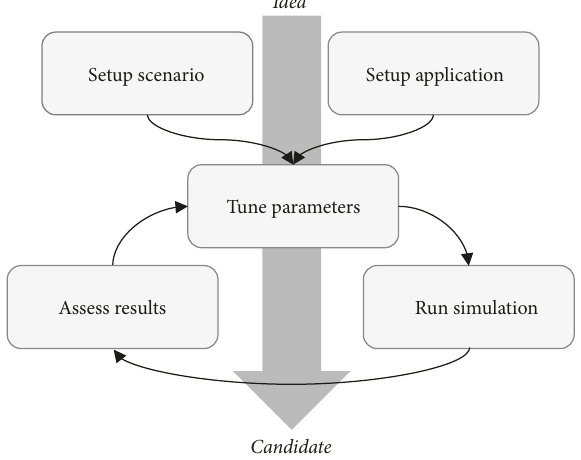
Figure 4: Iterative prototyping